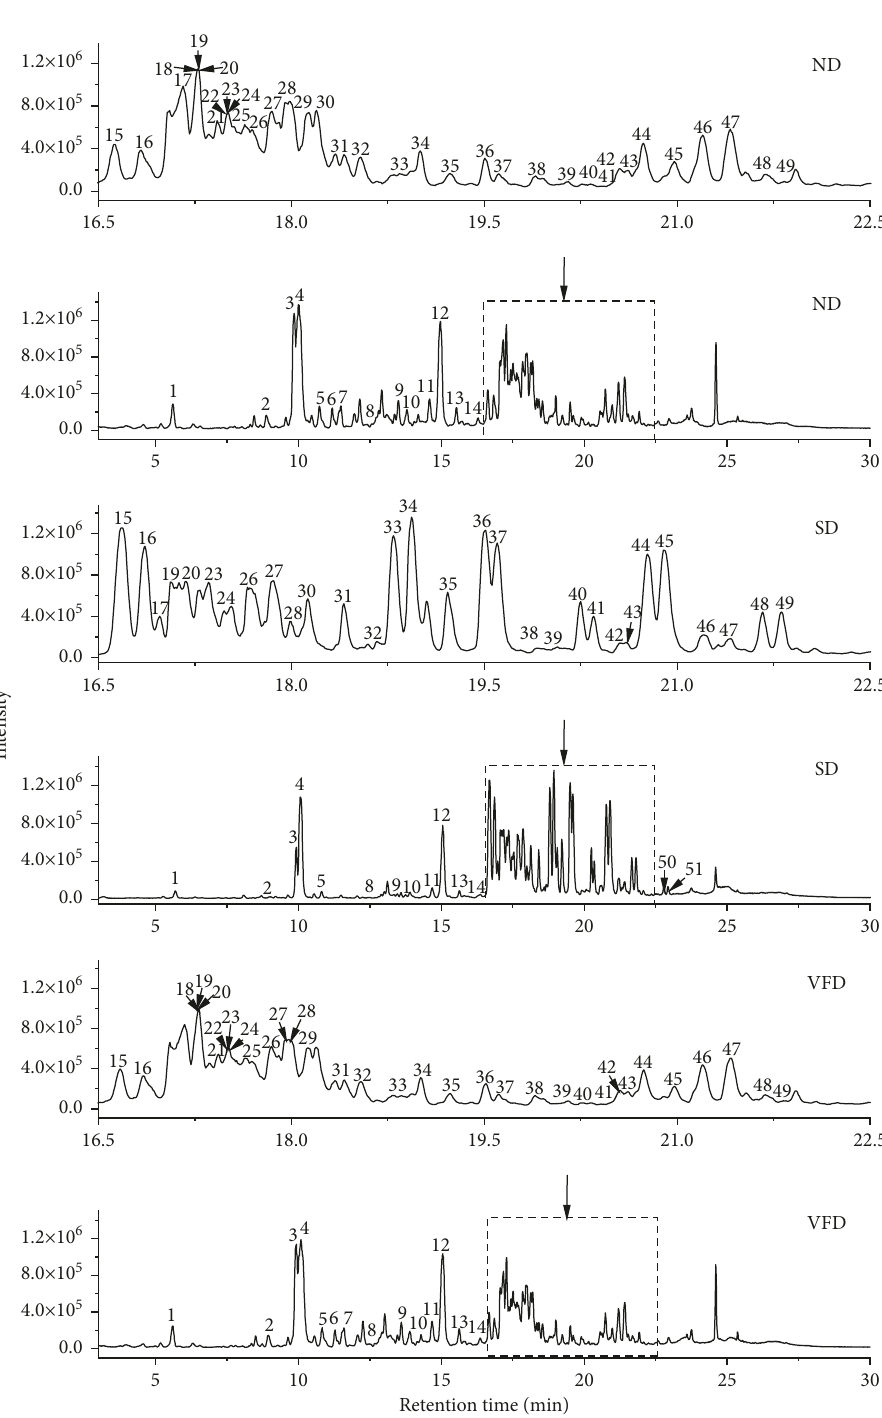
Figure 2: Base peak chromatogram of American ginseng of natural drying (ND), steam drying (SD), and vacuum freeze-drying (VFD) in the negative ion